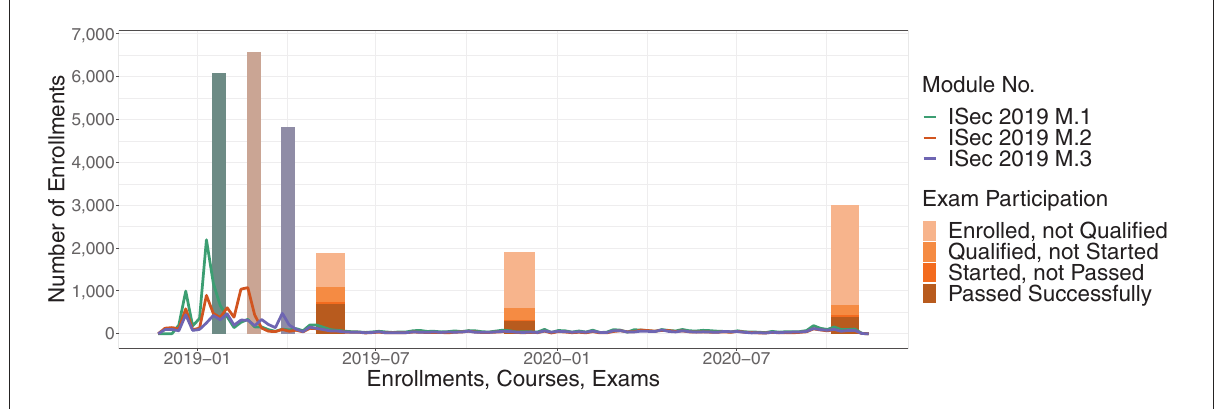
FIGURE4 ISec 2019 with three exam opportunities and the required modules. The lines show the weekly enrollments. The first three bars show the original course periods and the total enrollments in each of the course modules. The orange bars show the three final exams including their period.